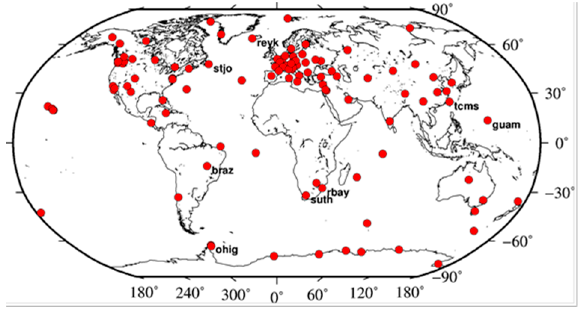
Figure 1. The selected global International GNSS Service (IGS) reference station distribution. The black texts indicate the name of the stations that mentioned in this paper.